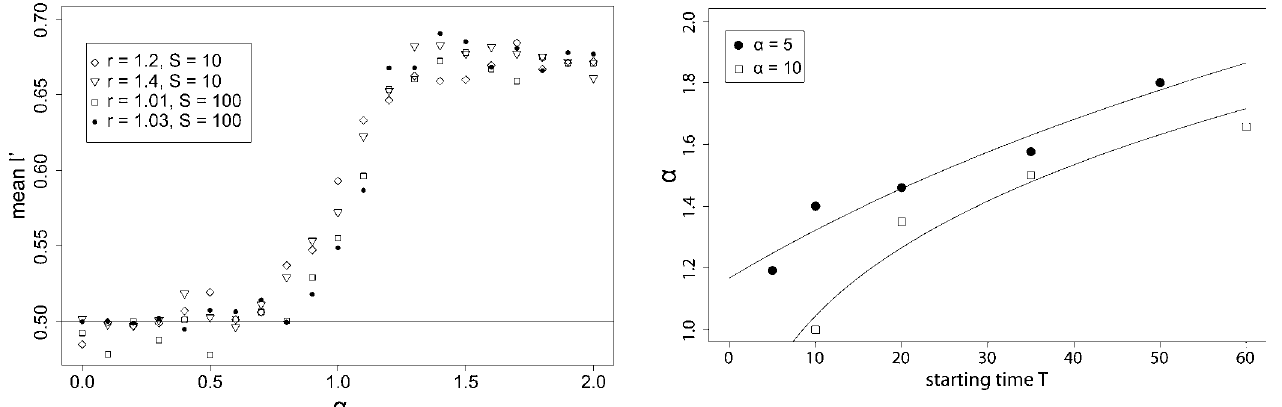
Figure 3. The Effect of the Starting Time T of the Fertility Inheritance Process on the a Value above Which It Is Possible to Detect Imbalanced Trees Tree imbalance was detected when more than 90% of the simulated trees were more unbalanced than expected under the neutral model (type I error ¼ 10%). The starting time is measured backward in time. The parameter s denotes the length of time, measured in generations, over which fertility inheritance occurred. The solid lines have been obtained using a linear regression between log a and log T. DOI: